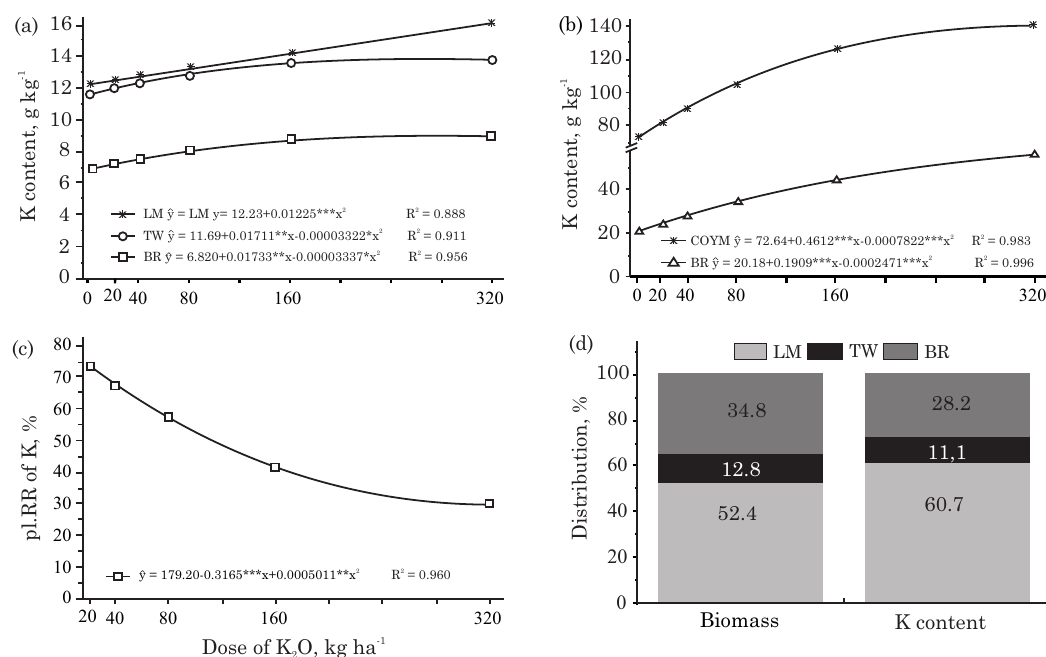
Figure 2. Potassium leaf concentration (LM), twigs (TW) and thick branches (BR) (a); K concentration in commercial yerba mate (COYM) and in BR (b); plant K recovery rate (pl.RR) (c); and yield distribution and K concentration in LM, TW and BR at a rate of 298 kg ha -1 K 2 O K-fertilized yerba mate (d). *, ** and *** significant at 5, 1 and 0.1 %,